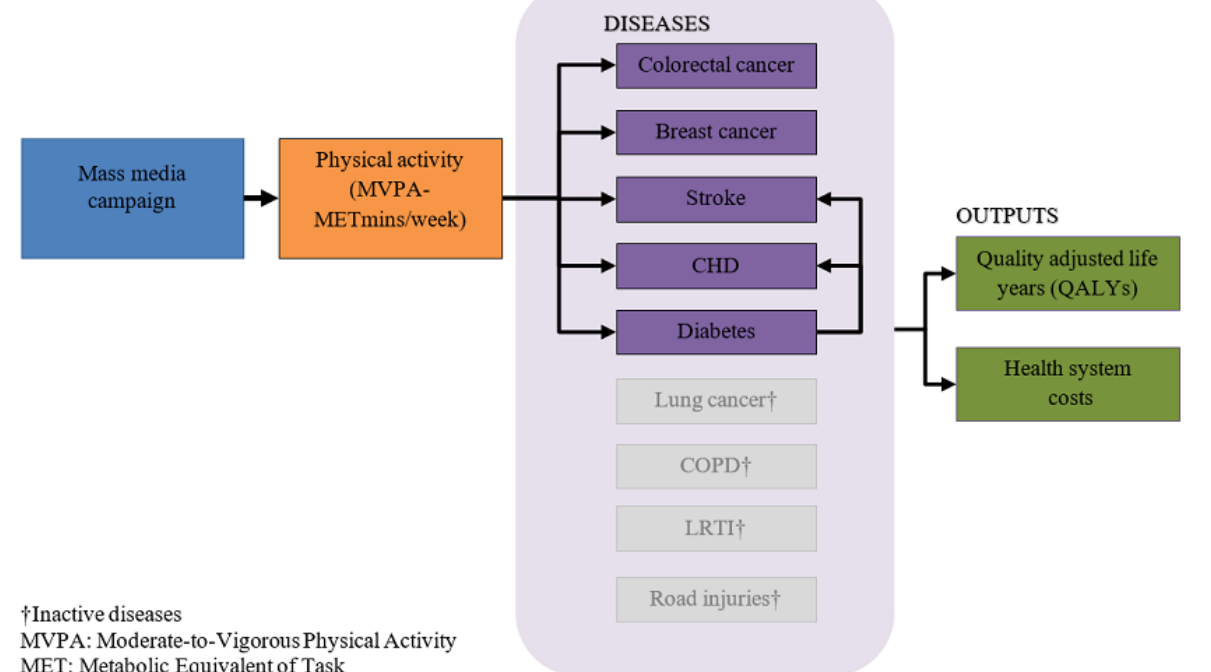
Figure 2. Conceptual diagram of model. CHD: coronary heart disease; COPD: chronic obstructive pulmonary disease; LRTI: lower respiratory tract